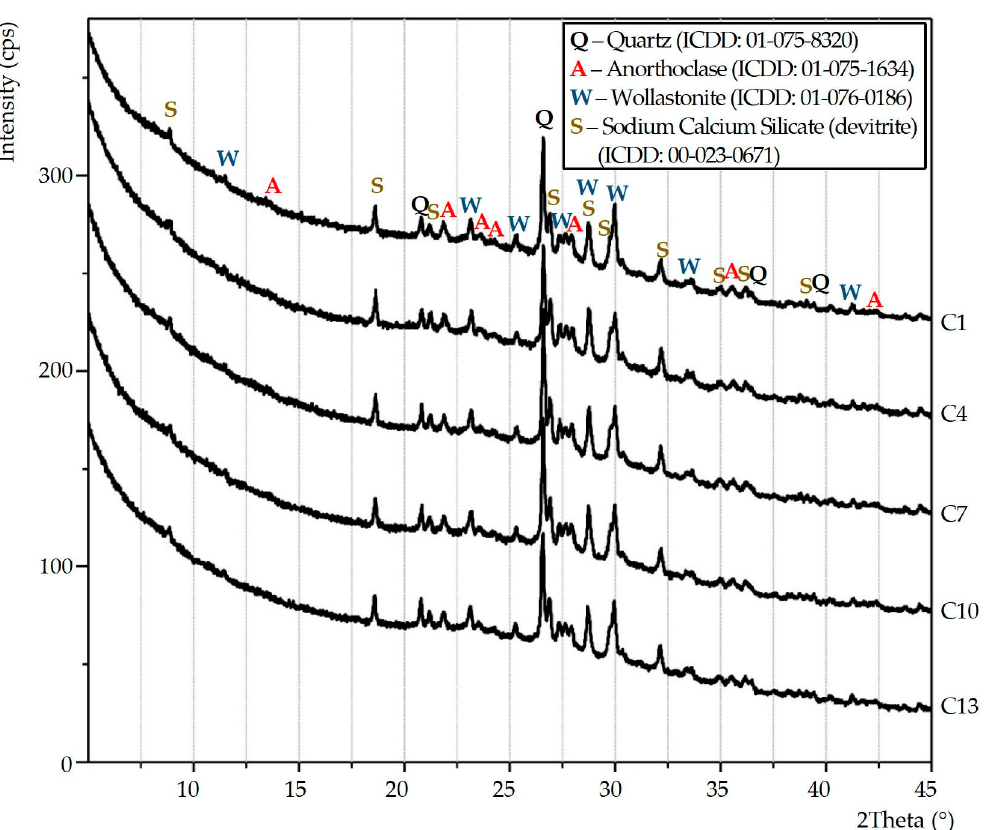
Figure 2. X-ray patterns of glass ceramics samples. Based on the results of the XRD of the samples (Figure 2), the qualitative phase composition of glass-ceramic materials has been identified. All samples of porous glass ceramics from siliceous rocks consist of a crystalline and amorphous phase. The presence of an amorphous phase in the samples is evidenced on all X-ray patterns by a non-monotonic change in the background (halo) in the scan range from 17 to 37 ◦ (2 θ ). The change of the amorphous halo depending on the type and amount of chlorides in the composition of the material has not been detected. The crystal phase of the control sample (C1) and chloride-modified samples (C4, C7, C10 and C13) consists of quartz [SiO 2 , ICDD: